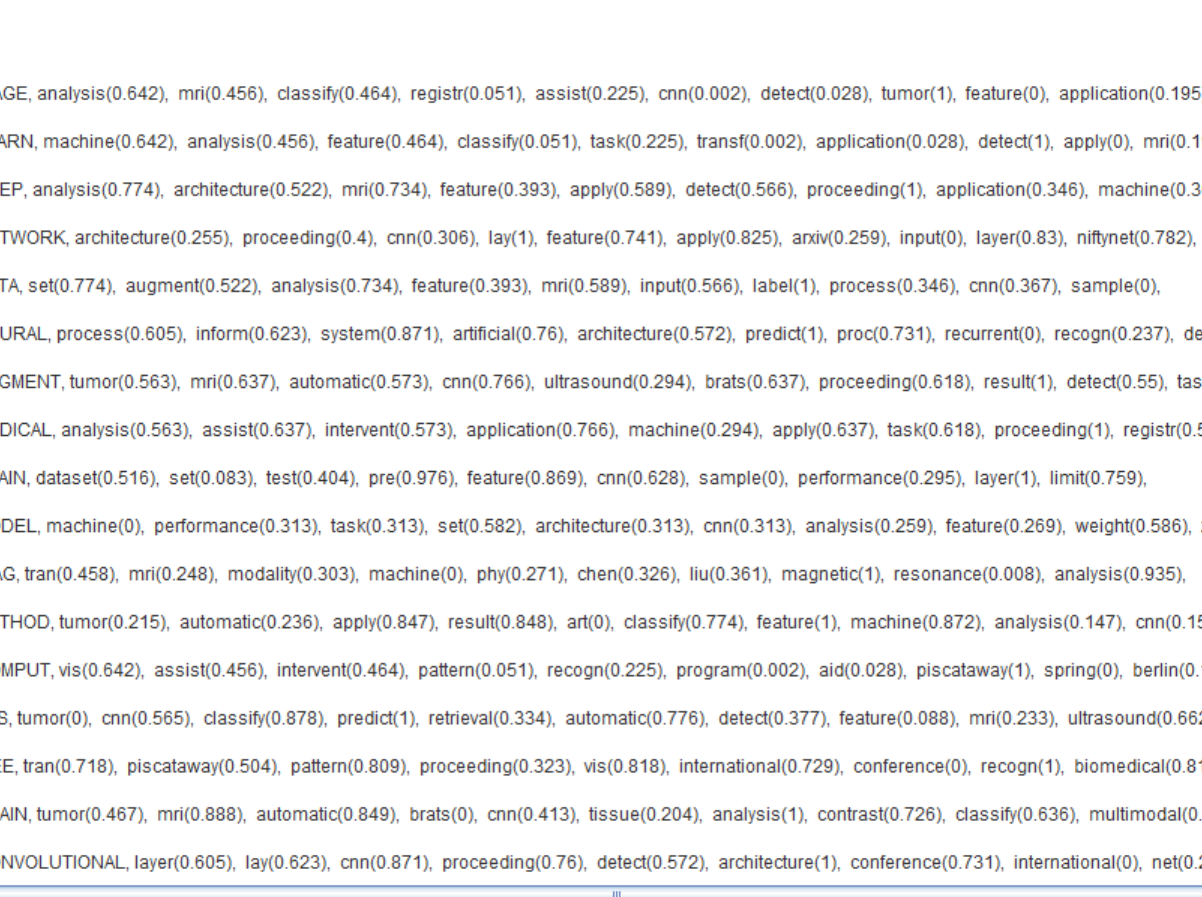
Figure 2. Generated Fuzzy Context Vector